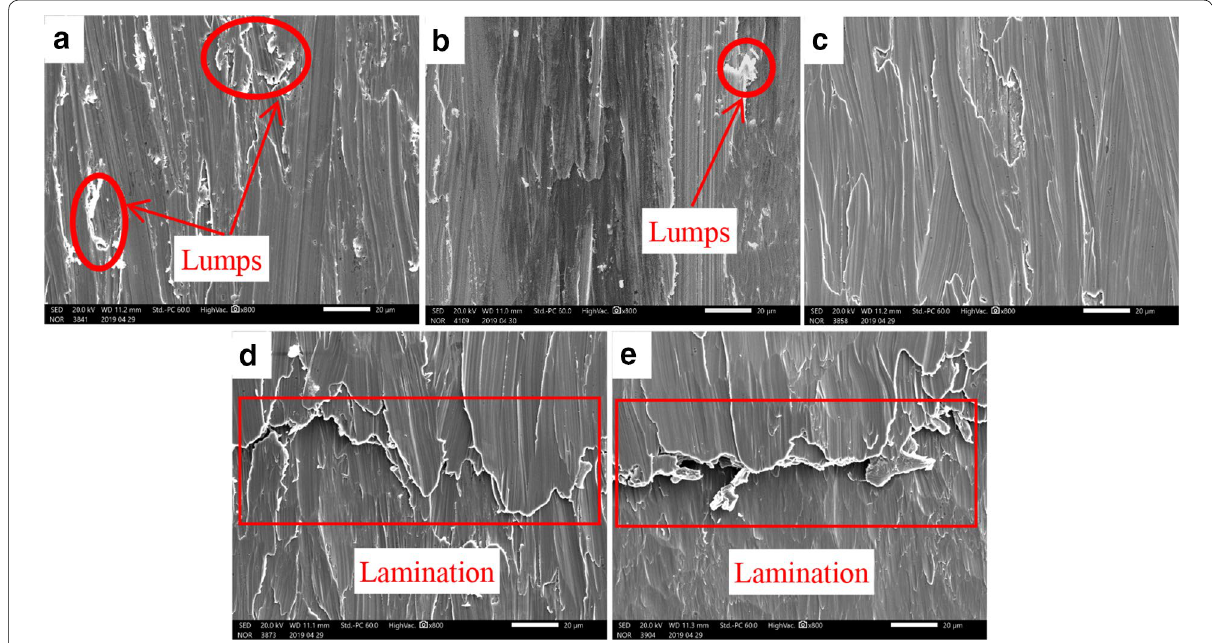
Fig. 3 Surface morphology of Cu plate after PRDG treatment for different times: a 10 s; b 15 s; c 20 s; d 25 s; e 30